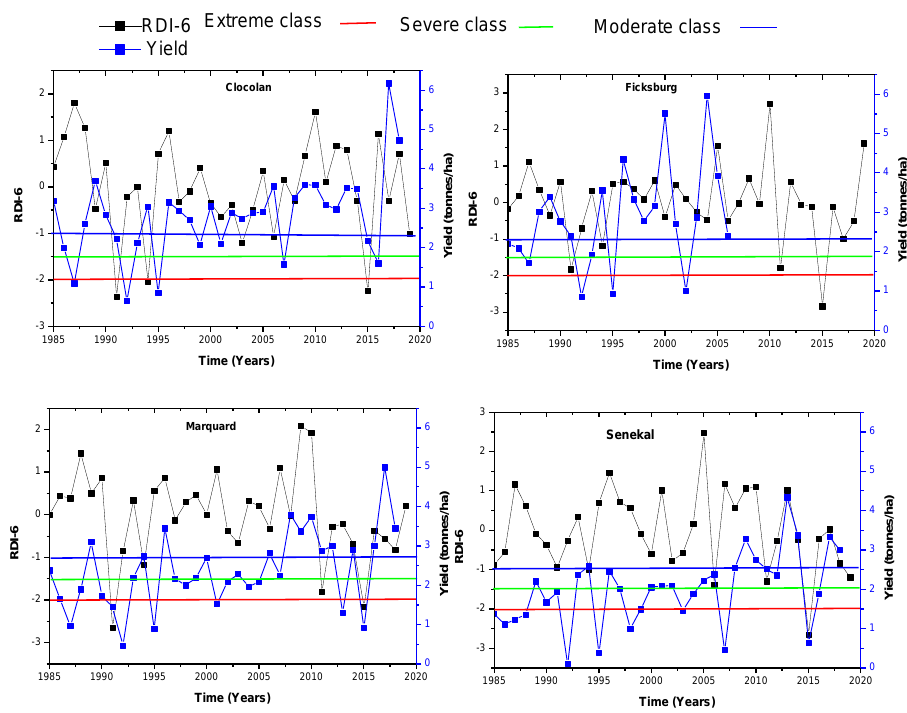
Figure 3. RDI-6 (black trendline) Setsoto municipality drought index (OND) and maize yield (blue trendline) for the period between 1985 and 2019.